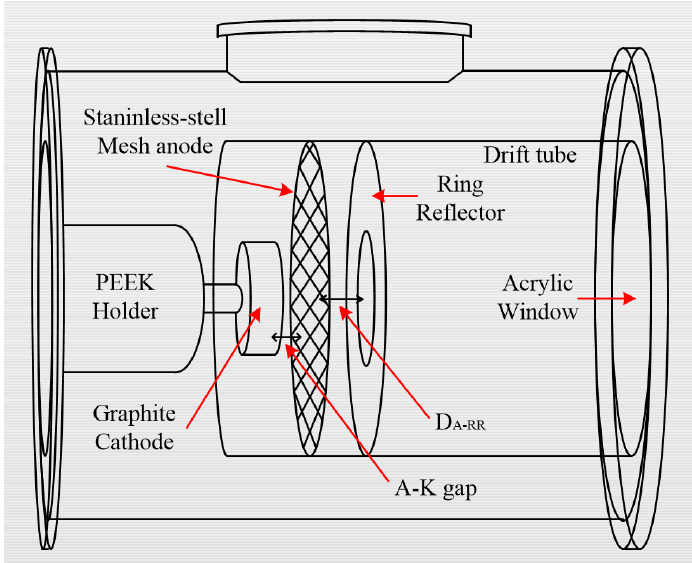
Figure 4. Inner structure of the axial vircator.